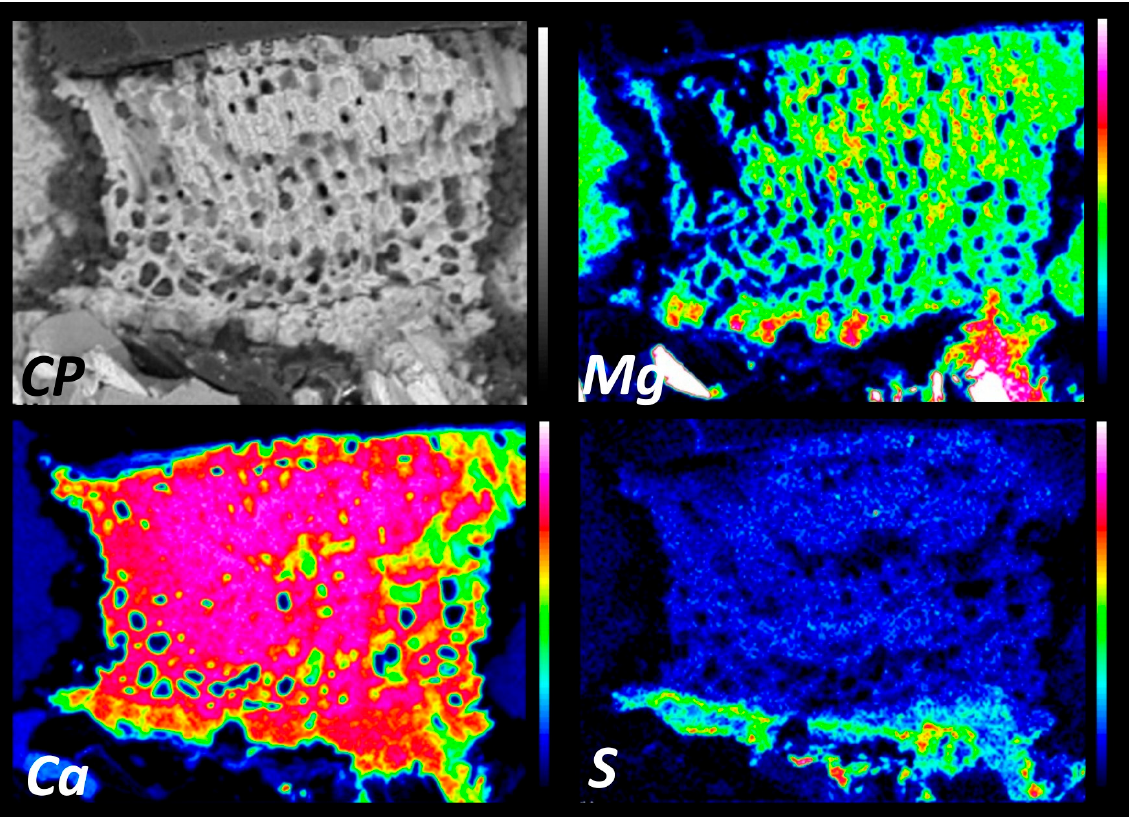
Figure 9. EMP-map 3, situated between two conceptacles. Sulfur is tied to the organic rich basal thallus part. Mg is tied to the high-Mg calcite of the cemented cell walls. Spatial resolution 1 × 1 µm, map dimensions 200 × 150 µm. Color scales: CP 1000–1500 cps, Mg 0–120 cps, Ca 0–900 cps, S 0–80 cps.